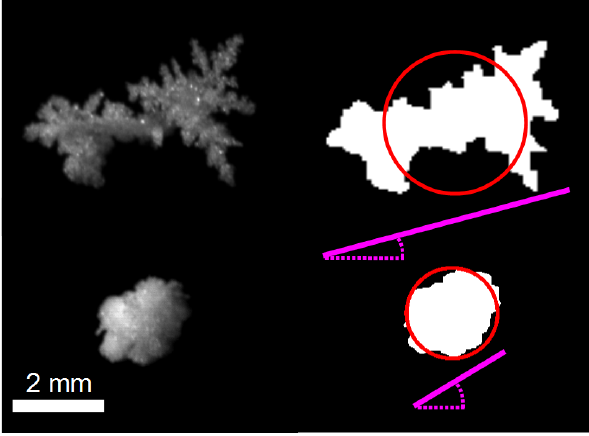
Figure 1. (left) MASC single-view images of two snowflakes: (top) aggregate snowflake and (bottom) heavily rimed graupel snow. (right) Illustration of the corresponding projection images of perimeter P (highlighted white regions) and area-equivalent cir- cles of circumference C (outlined in red), leading to complex- ity values χ = P of (top) χ = 2 . 1 and (bottom) χ = 1 . 2. Derived C snowflake diameters D and orientation angles θ are indicated by solid and dotted magenta lines, respectively: (top) D = 5 . 7mm, θ = 16 ◦ ; (bottom) D = 2 . 3mm, θ = 31 ◦